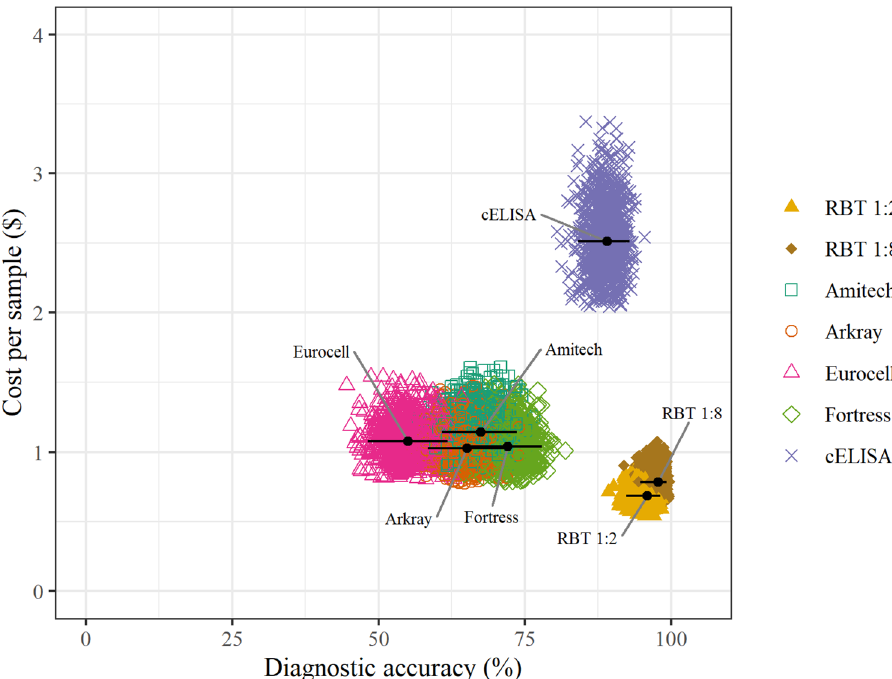
Figure 2. Probabilistic sensitivity analysis of the cost per sample of each of the index tests (estimates indicated by colored symbols) with their corresponding diagnostic accuracy estimate (black dots; 95% confidence intervals represented with black lines). RBT the Rose Bengal test, cELISA competitive enzyme-linked immunosorbent